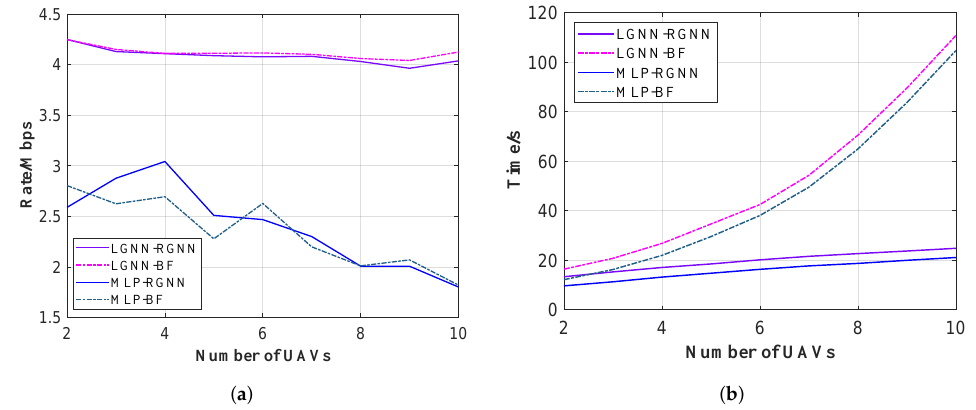
Figure 10. The relation of |V u | on communication rate and computation time with constant |V s | = 20. ( a ) The relation of |V u | on communication rate. ( b ) The relation of |V u | on computation time.